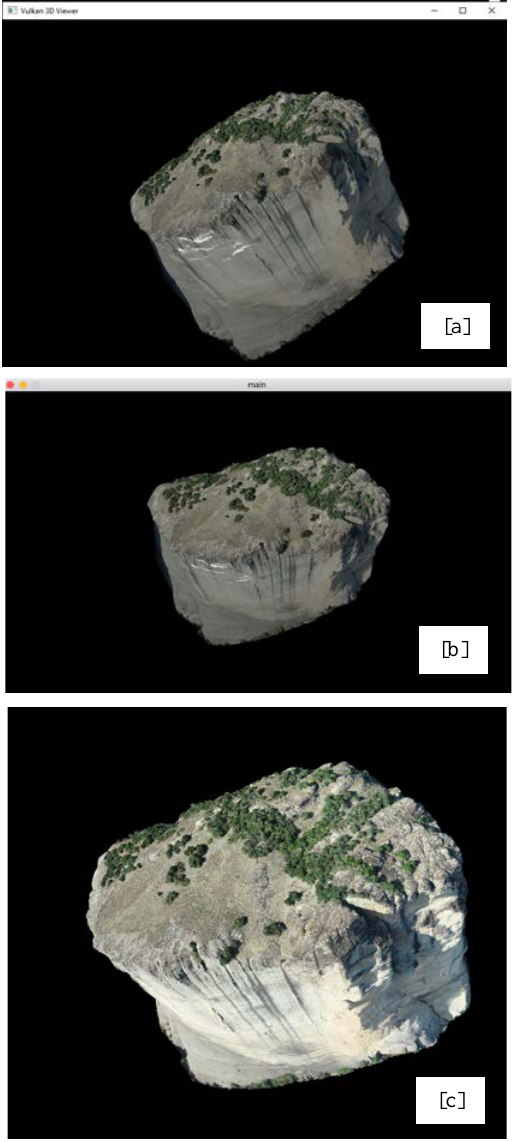
Figure 2. Visual output of the Vulkan-based 3D rendering on (a) Windows 10, (b) MacOS 10.15.14 and (c) Android 9.